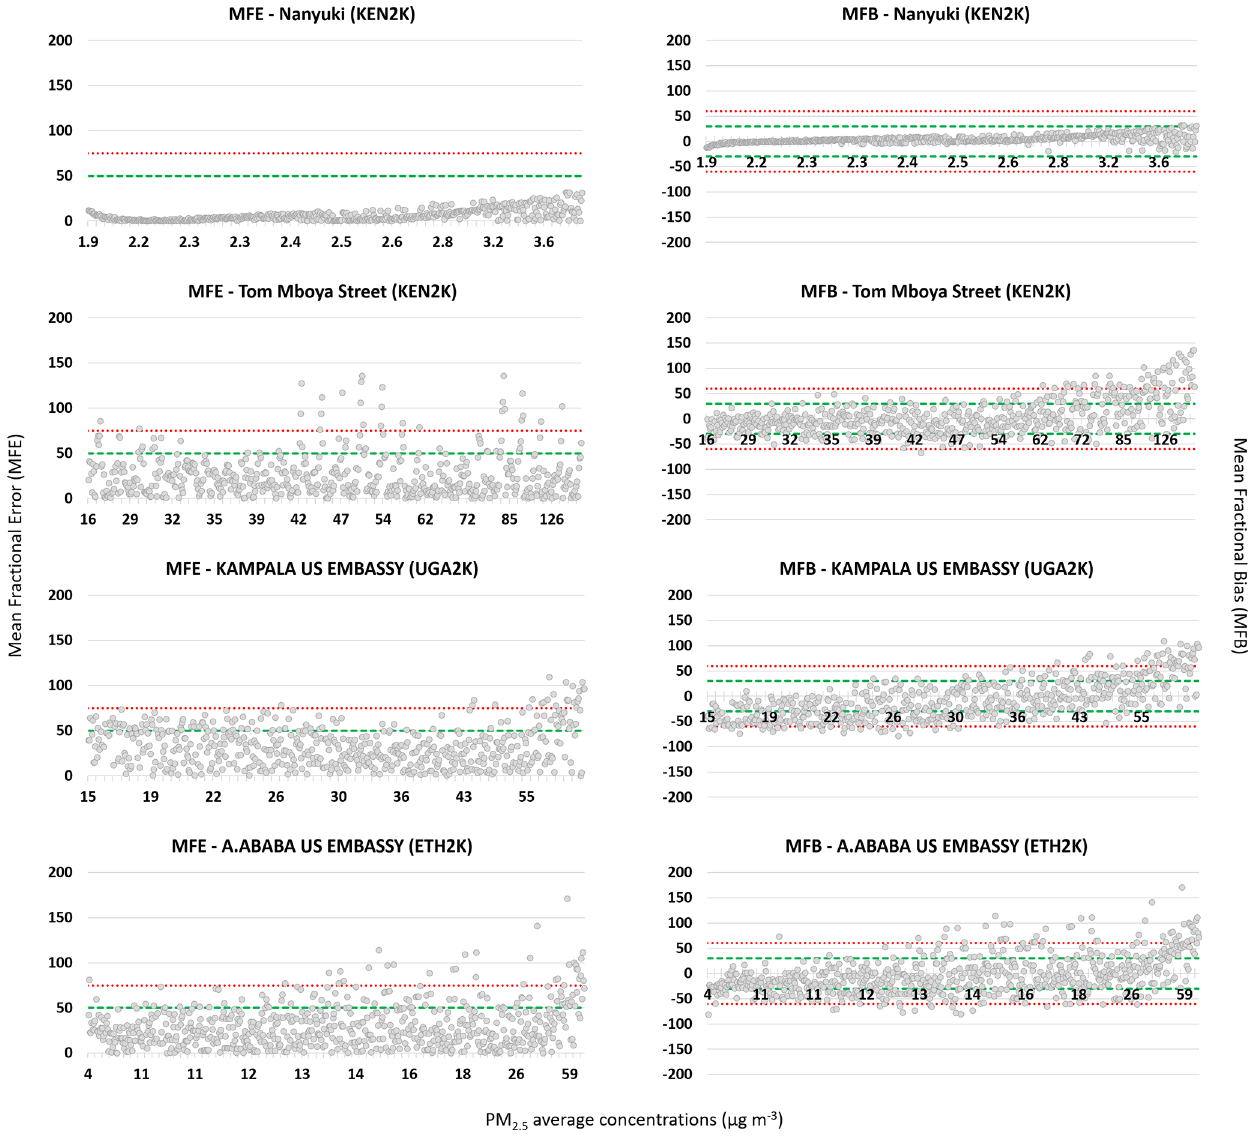
Figure 6. The hourly mean fractional bias (MFB) and mean fractional error (MFE) values calculated for the Tom Mboya Street and Nanyuki (KEN2K), Kampala US embassy (UGA2K), and Addis Ababa US embassy (ETH2K) locations for the analysis period against hourly con- centrations of PM 2 . 5 . The green lines represent the MFB range ± 30% and the MFE limit of 50%, for which the model performance can be considered reliable; the red lines represent the MFB range ± 60% and the MFE limit of 75%, for which model performance can be increased by diagnostic analysis of the chemical precursors of PM 2 . 5